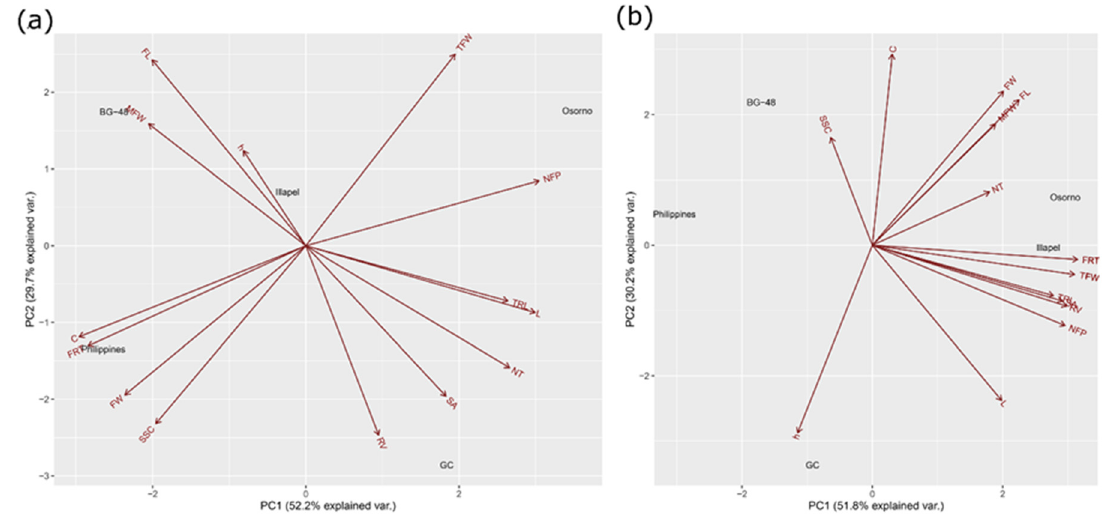
Figure 5. Principal component analysis (PCA) biplot showing variation explained for fruit yield and quality traits, water productivity and root system architecture of L. siceraria rootstocks grafted onto watermelon cv. Santa Amelia F1 and evaluated at the irrigation level of 100%-IR1 ( a ) and 50%-IR3 ( b